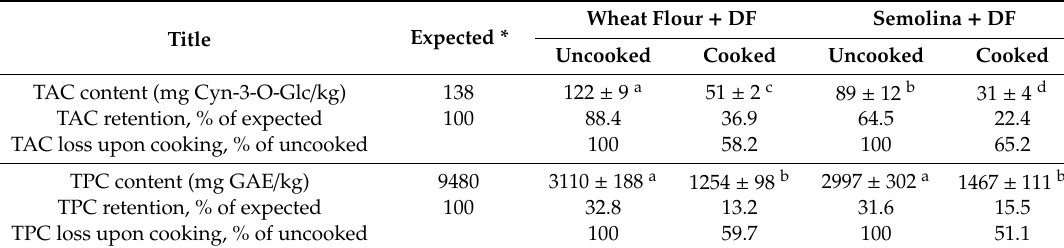
Table 2. E ffi ciency and stability of phenolics